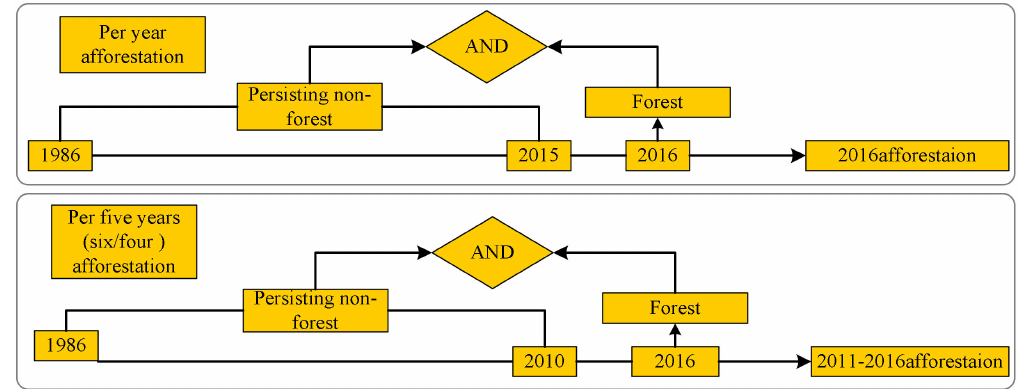
Figure 6. The method for the identification of annual or per five (or four, or six) years forest cover change due to